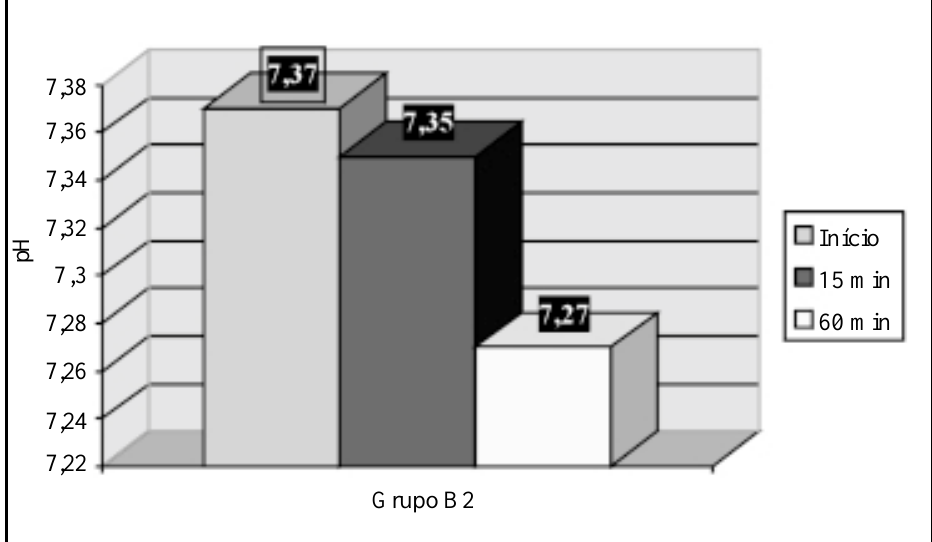
a 16mmHg: antes da insuflação da cavidade, 2